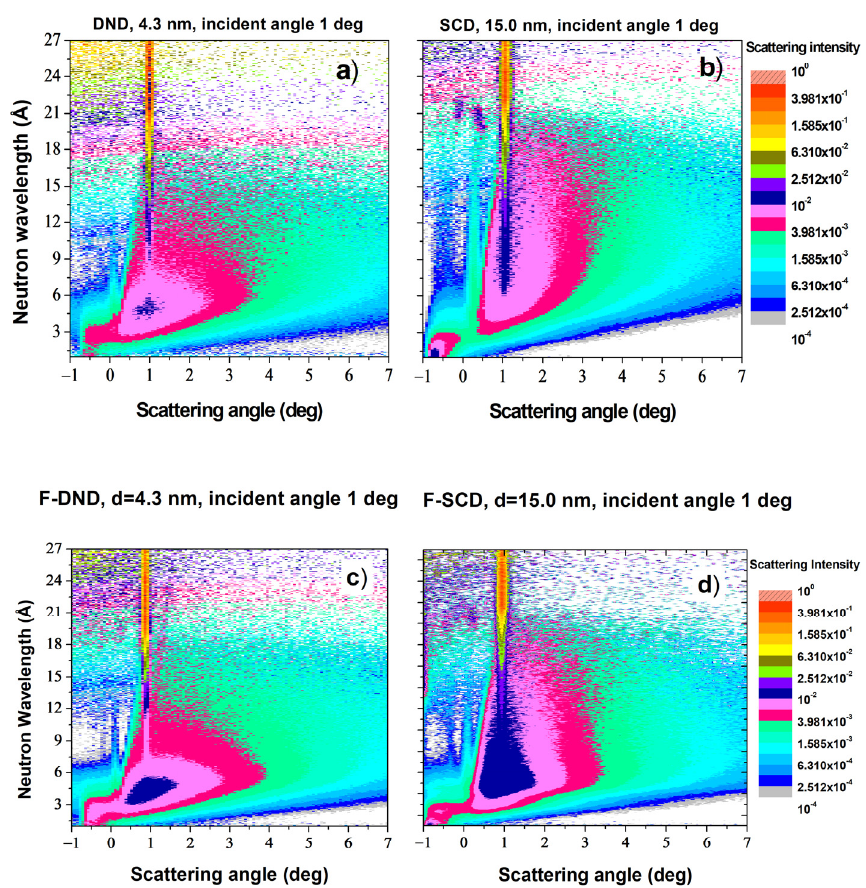
Figure 7. Probability of neutron scattering from the surface of ND samples as a function of the neutron wavelength (vertical axis) and the scattering angle in the direction perpendicular to the plane of the sample (horizontal axis). Different colors are scaled to the proportion of neutrons registered in the detector normalized by the incident beam flux. Samples: ( a ) DND; ( b ) SCD; ( c ) F-DND; ( d ) F-SCD. In all cases, the angle of incidence of the neutron beam onto the sample was 1°. The narrow vertical line of intensity with a reflection angle of 1° in Figure 7a–d cor-